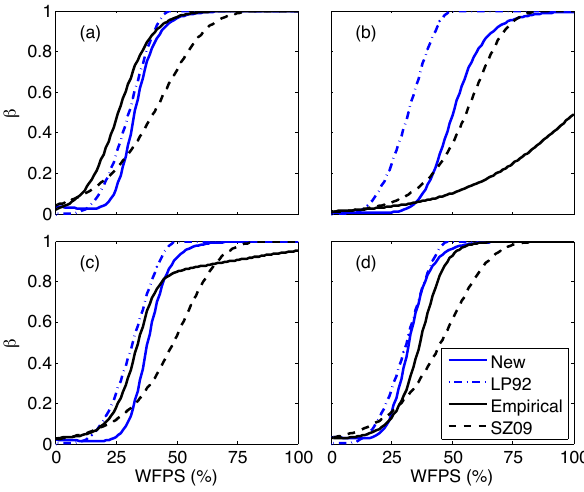
Figure 3 . Comparison of predicted soil evaporation efficiency ( ! ) by the measurement- 2 Fig. 3. Comparison of predicted soil evaporation efficiency ( β) by the measurement-derived empirical equations and Eqs. (13) and derived empirical equations and Eqs. (13) and (16) for the four soils listed in Table 2. For 3 (16) for the four soils listed in Table 2. For all cases, we assumed all cases, we assumed r a = 50 s m -1 and D 0 = 2.4 ! 10 " 5 m 2 s -1 . As specified by the 4 vestigators of the original publications, the TSCV thicknesses are 1, investigators of the original publications, the TSCV thicknesses are 1, 5, 2, and 2 cm for 5 5, 2, and 2cm for panels (a) , (b) , (c) , and (d) , respectively. panels (a), (b), (c), and (d), respectively. 6